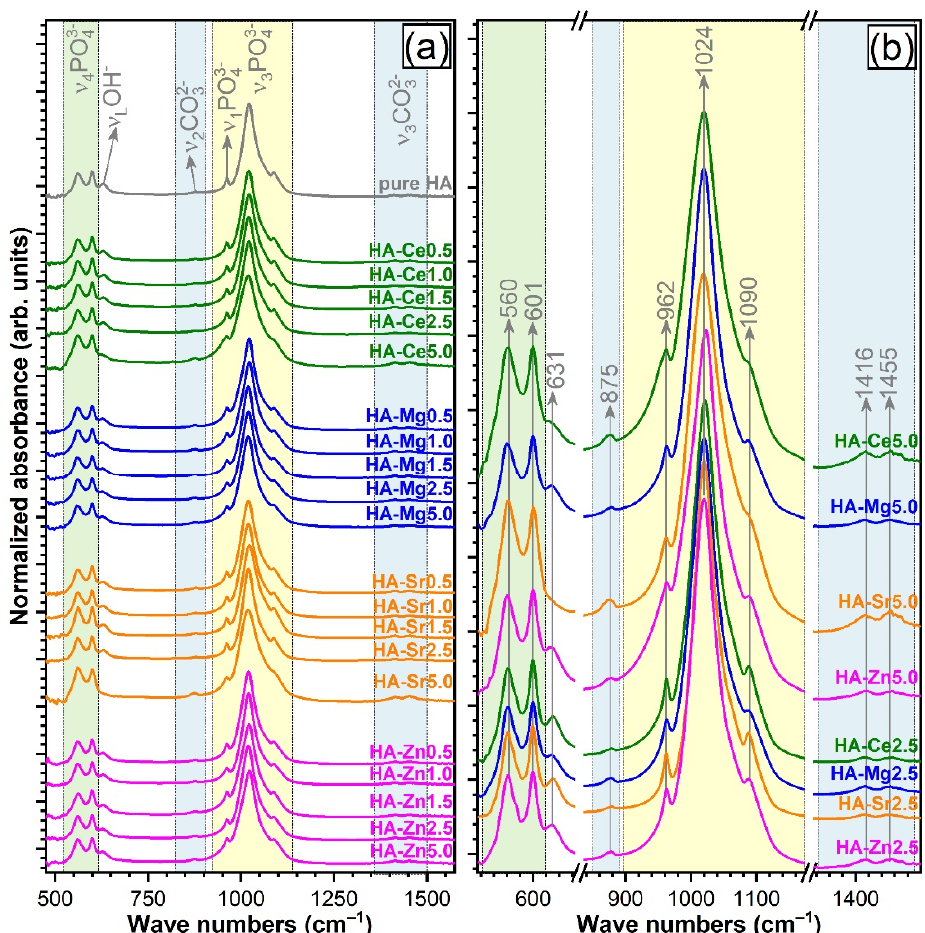
Figure 4. ( a ) Fourier-transform infrared spectra in attenuated total reflectance mode (FTIR-ATR) of all pure and substituted HA (0.5 to 5 at.%). ( b ) Comparison of FTIR-ATR spectra for HAs with substituent concentration of 2.5 and 5 at.%.